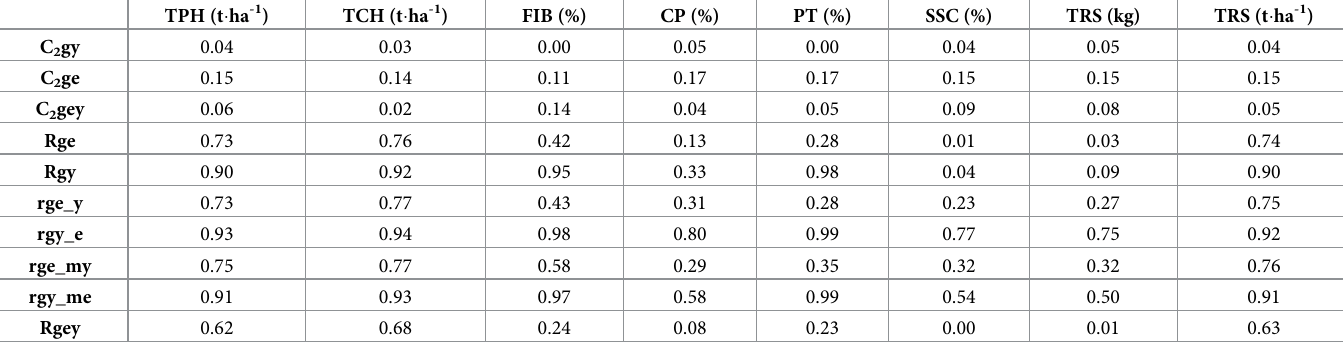
C2gy, coefficient of determination of the effects of genotype × year interactions; C2ge, coefficient of determination of the effects of genotype × environment interactions; C2gey, coefficients of determination of the effects of genotype × environment × year interactions; rge, genotypic correlation through the environment valid for any year; rgy, genotypic correlation over the two years valid for any environment; rge_y, genotypic correlation through the environment in a given year; rgy_e, genotypic correlation over the two years in a given environment; rge_my, genotypic correlation across environments for the average of all years; rgy_me, genotypic correlation over the years for the average of all environments; rgey, genotypic correlation across environments and years; TCH, tons of sugarcane per hectare; TPH, tons of pol per hectare; FIB, fiber; CP, corrected pol%; PT, purity; SSC, soluble solids content; TRS, total recoverable sugars; and TRS/t � ha -1 , total recoverable sugars per hectare.